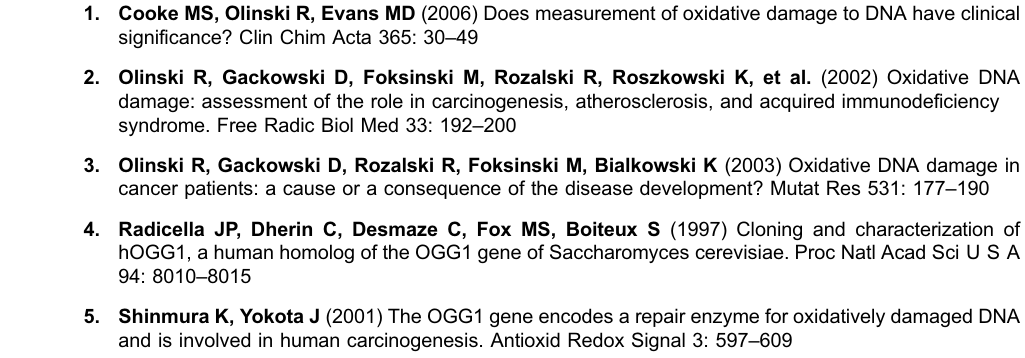
S1 Fig. Lack of correlation between PARP-1 and OGG1 proteins in normal tissues. S2 Fig. Western analysis of OGG1 protein (36 and 38 kDa) in colon tissues of CRC patients in relation to Lamin A/C (62 and 69 kDa). S1 Table. Comparison of mRNA expression of PARP-1 and OGG1 in leukocytes. S2 Table. mRNA level of c-MYC in normal colon, adenomas and carcinomas. S3 Table. Comparison of 8-oxodGuo level in leukocytes and tissues of AD and CRC patients in relation to healthy